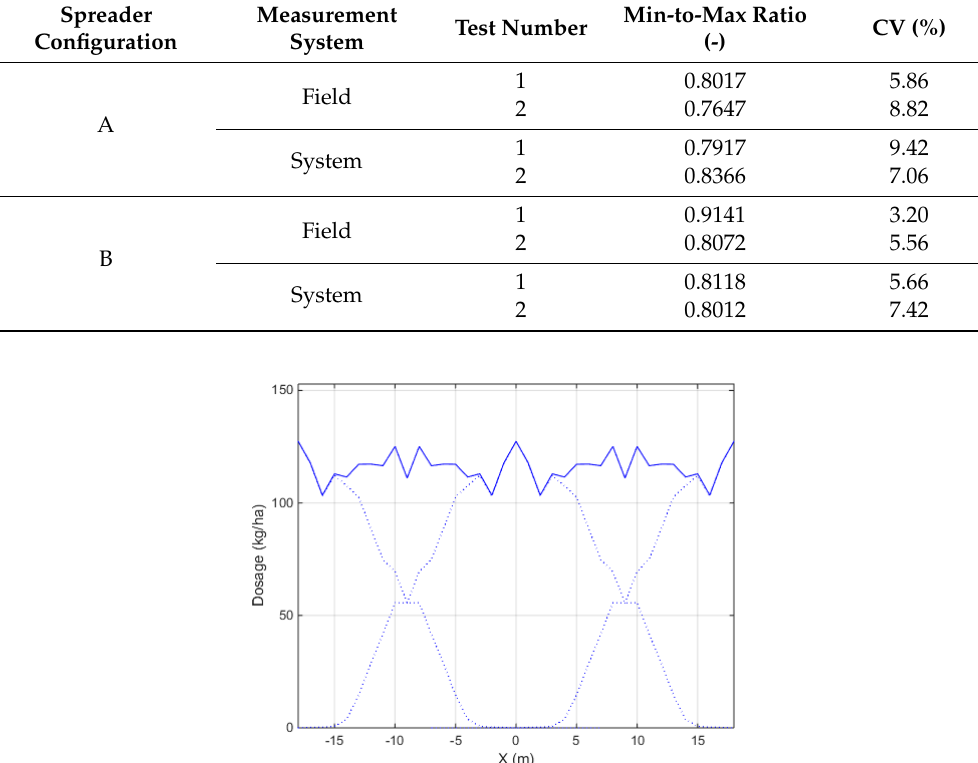
Table 9. Minimum to maximum ratio and Coefficient of Variation (CV) for the total transverse spread pattern at working width specified by the manufacturer (12 m for configuration A, 18 m for configuration B). Transverse distributions for both replicates with the collection trays on the field and with the system developed in this paper were used.